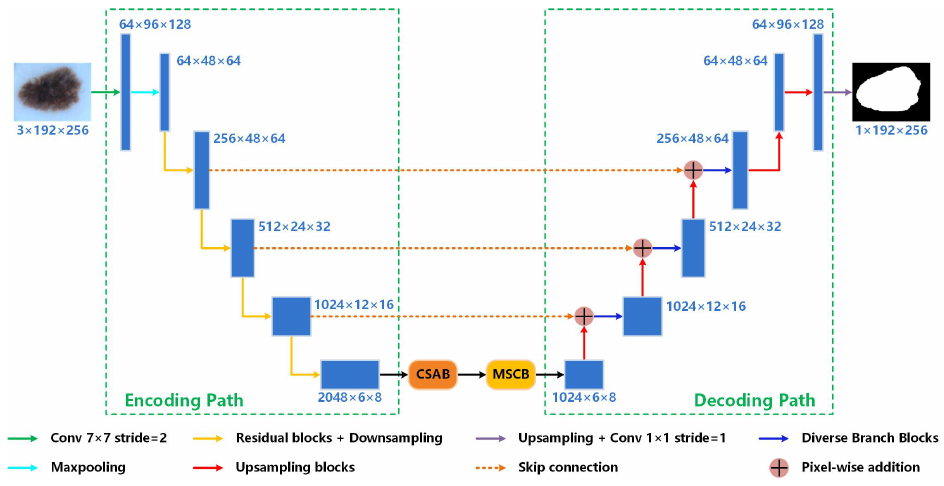
Figure 2. Diagram of the proposed network